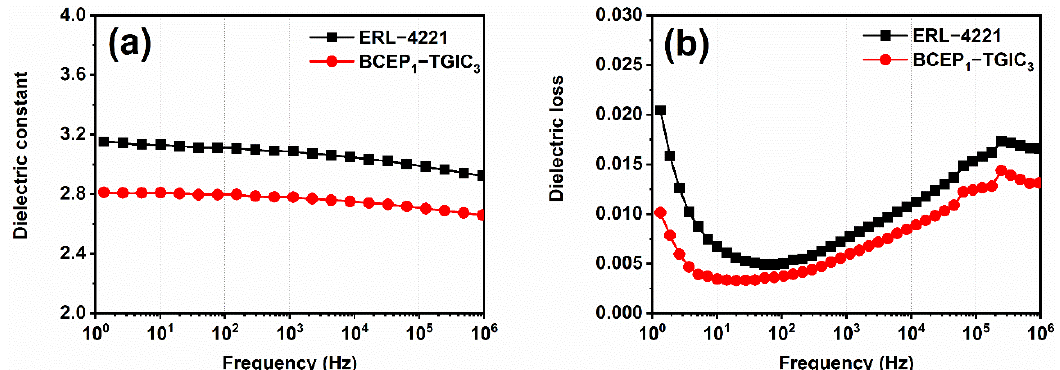
Figure 5. Dielectric constant ( a ) and dielectric loss ( b ) versus the frequency curves of the cured ERL – 4221 and BCEP 1 – TGIC 3 .